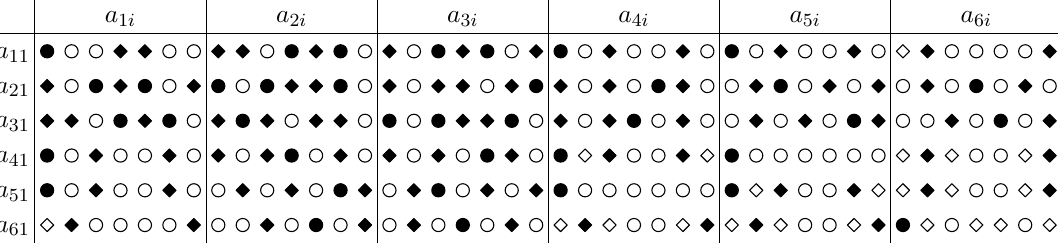
Table 1 . The adjacency relations of the A coordinates of Conf 7 ( P 3 ) . The symbols correspond to the following possible relations between different letters, as explained in the main text.